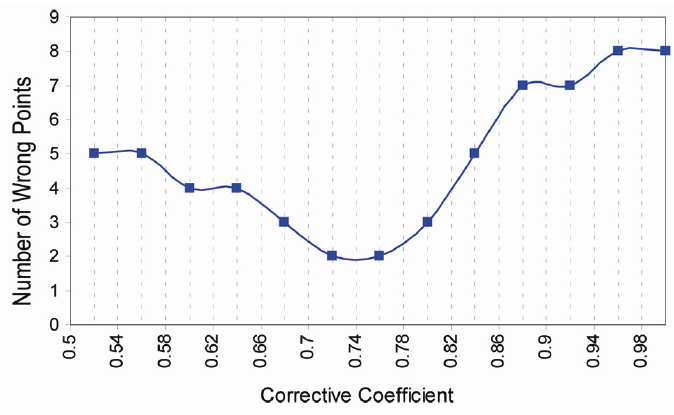
Fig. 12. The influence of different corrective coefficients on number of wrong points